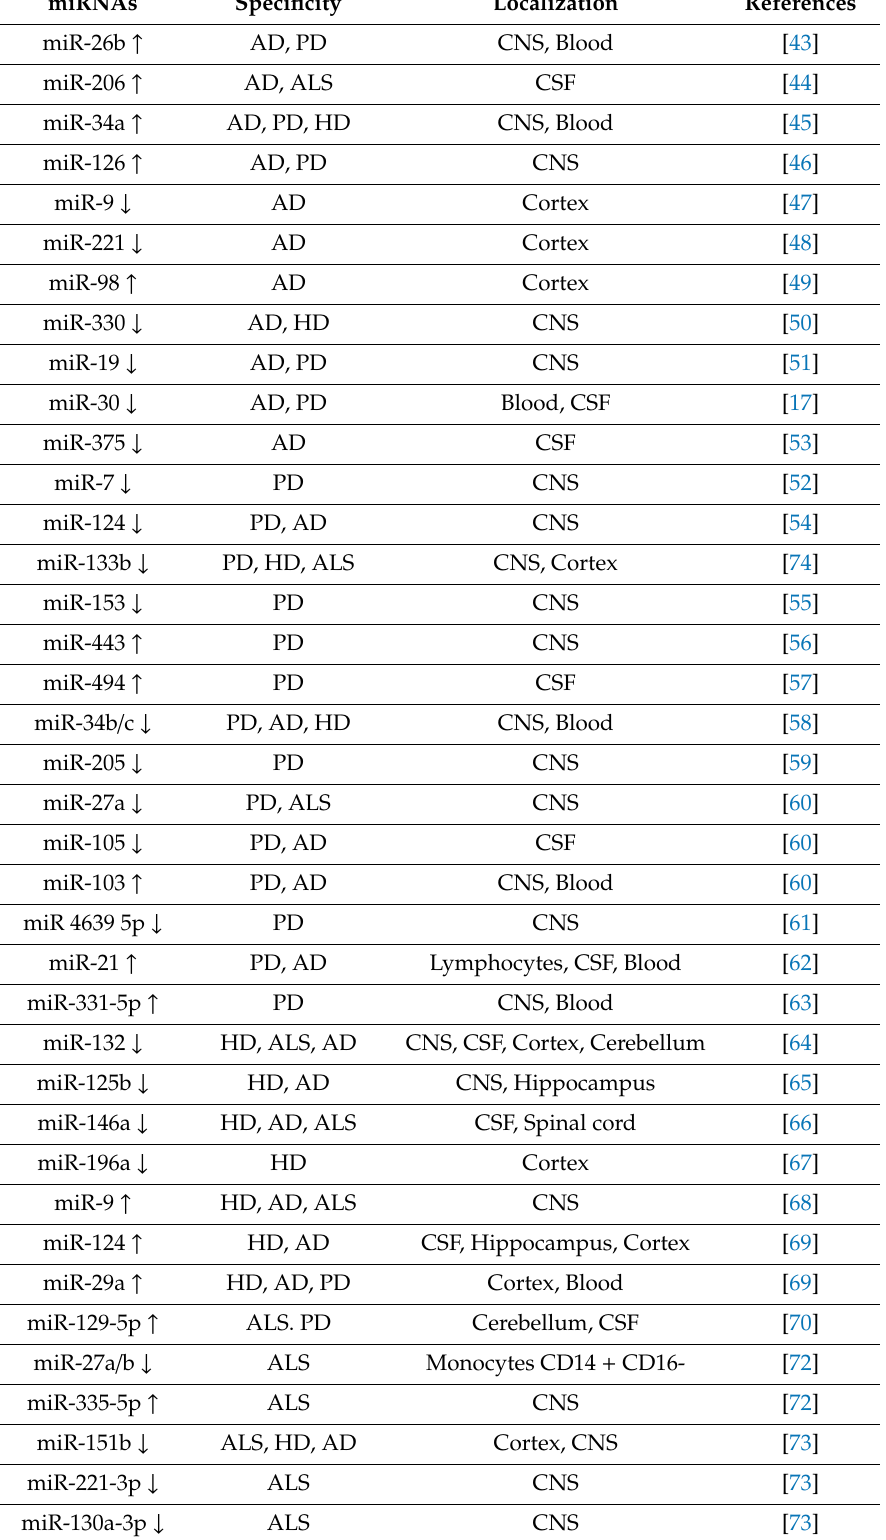
↑ = miRNA upregulated in related disease; ↓ = miRNA downregulated in related disease. AD = Alzheimer’s disease; PD = Parkinson’s disease; HD = Huntington’s disease; ALS = Amyotrophic lateral sclerosis; CNS = central nervous system; CSF = cerebrospinal